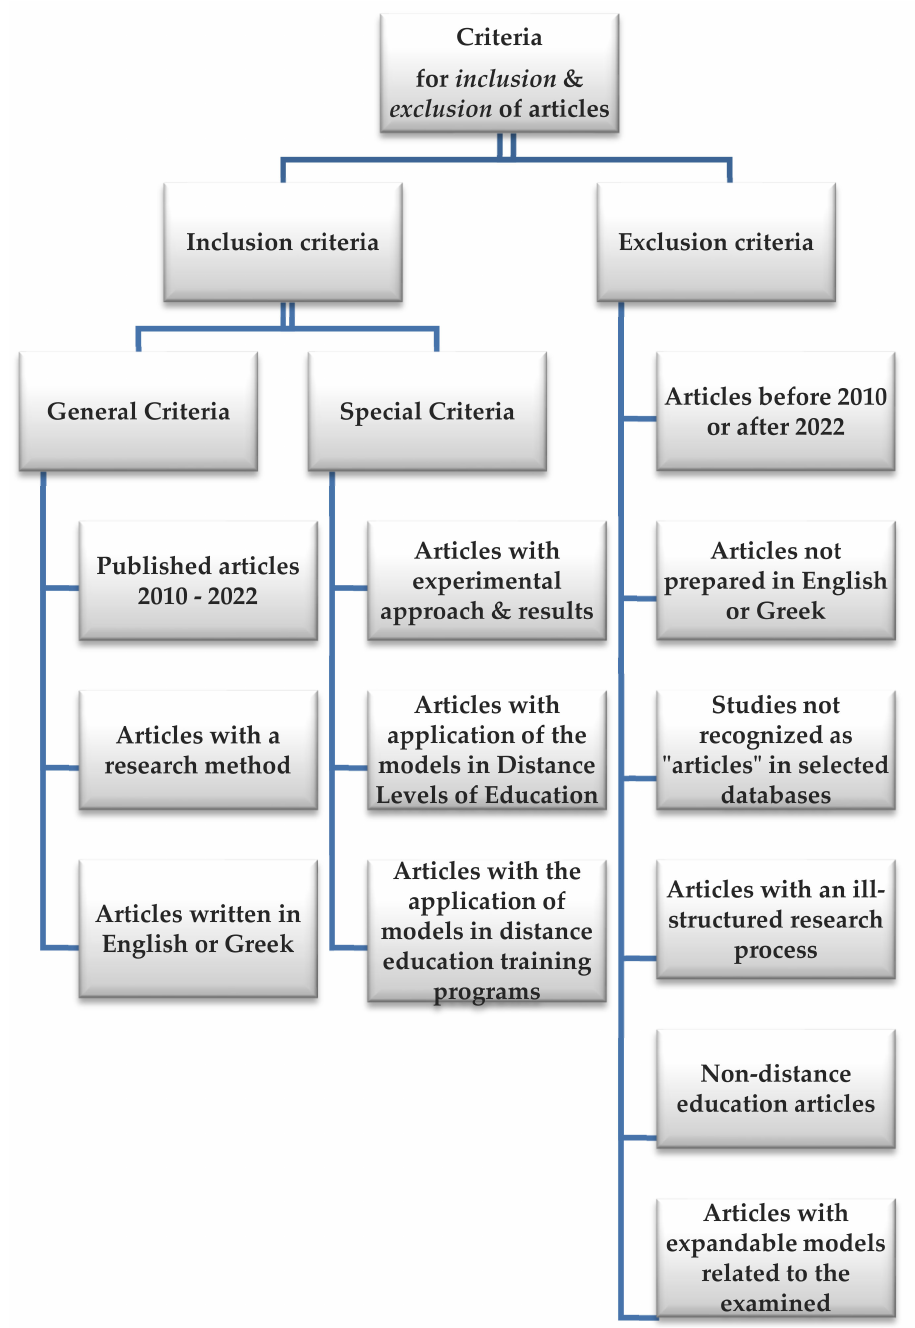
Figure 3. Criteria for inclusion and exclusion of